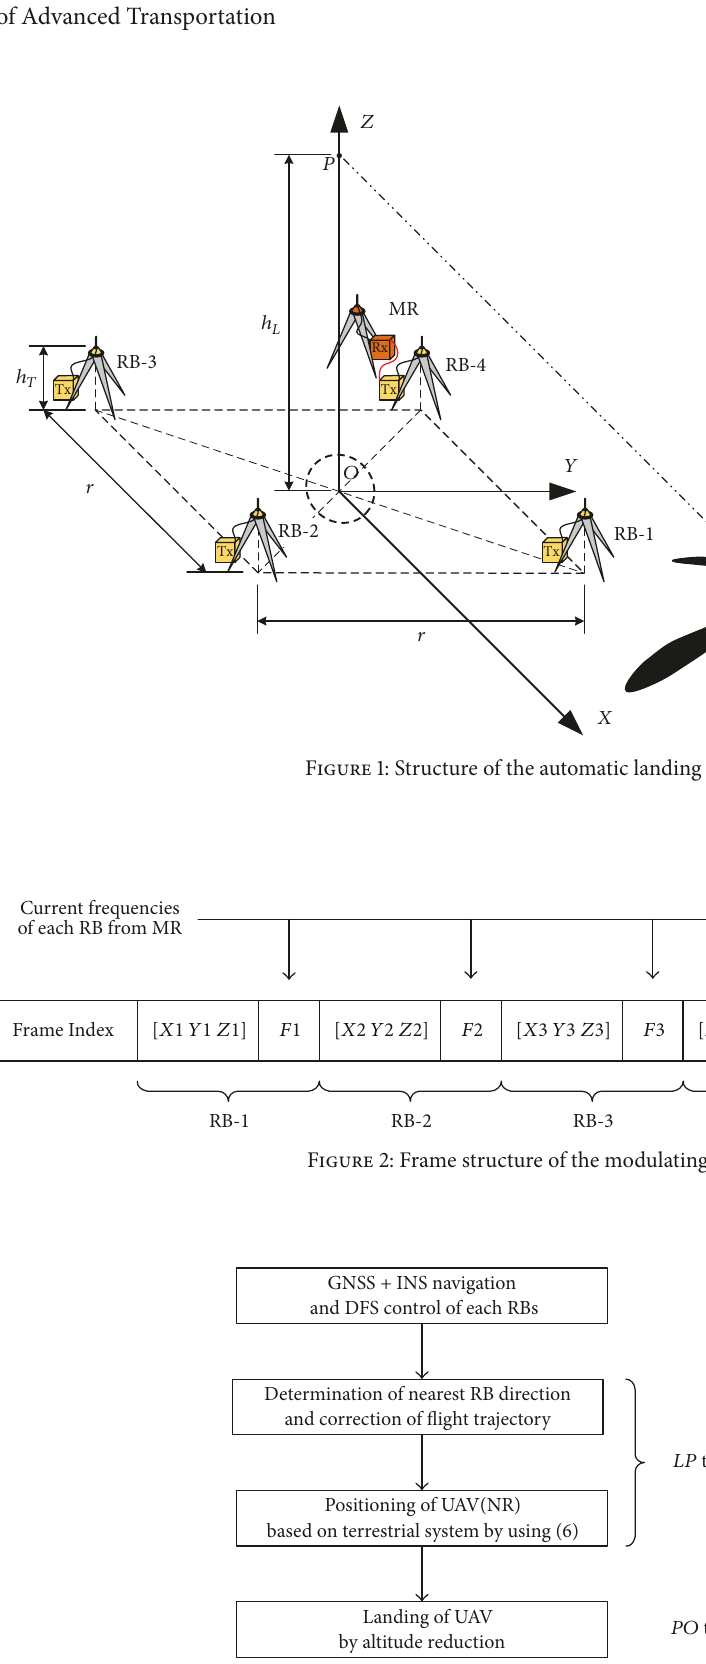
Figure 3: Generalized algorithm of the precise UAV positioning at the landing